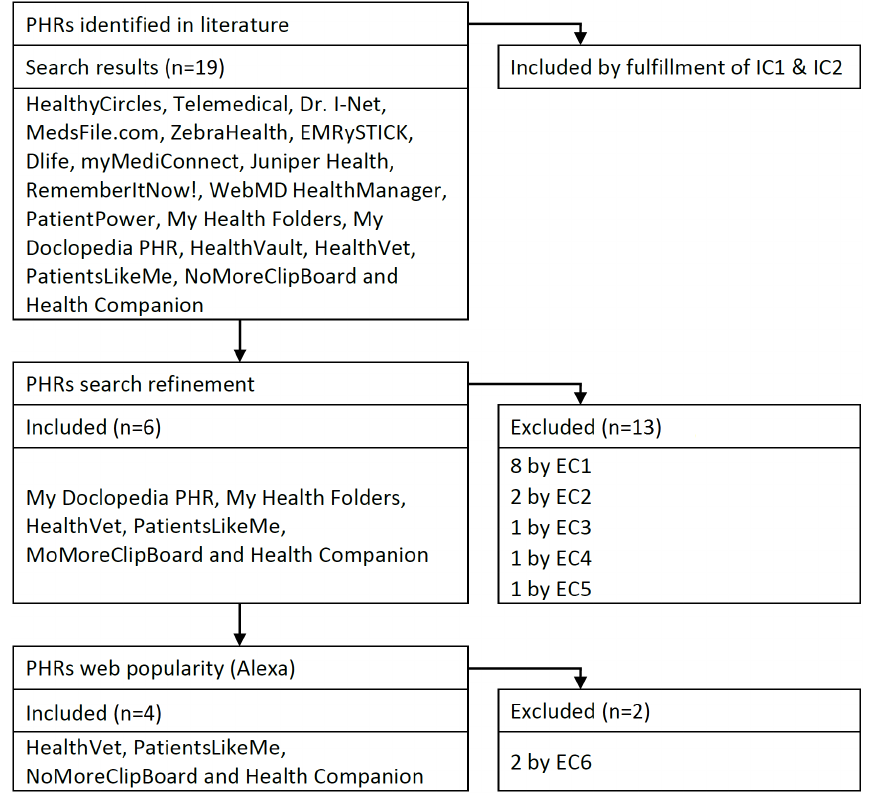
Figure 1. Research flow